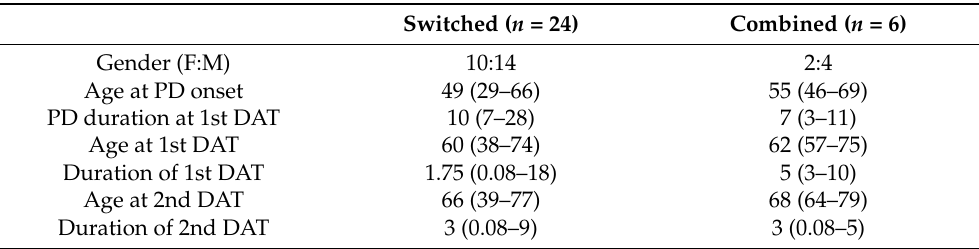
Table 1. Gender distribution, age at onset of Parkinson’s disease (PD), PD duration at 1st Device- Aided Therapy (DAT), age at 1st DAT, duration of 1st DAT, age at 2nd DAT, and duration of 2nd DAT through June 2021 for patients who switched and patients who combined DAT. Median values and range (in parentheses) are shown. F = females, M =